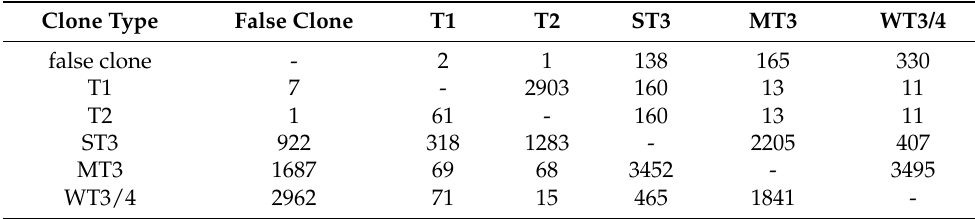
Table 7. Distribution of misclassified clone